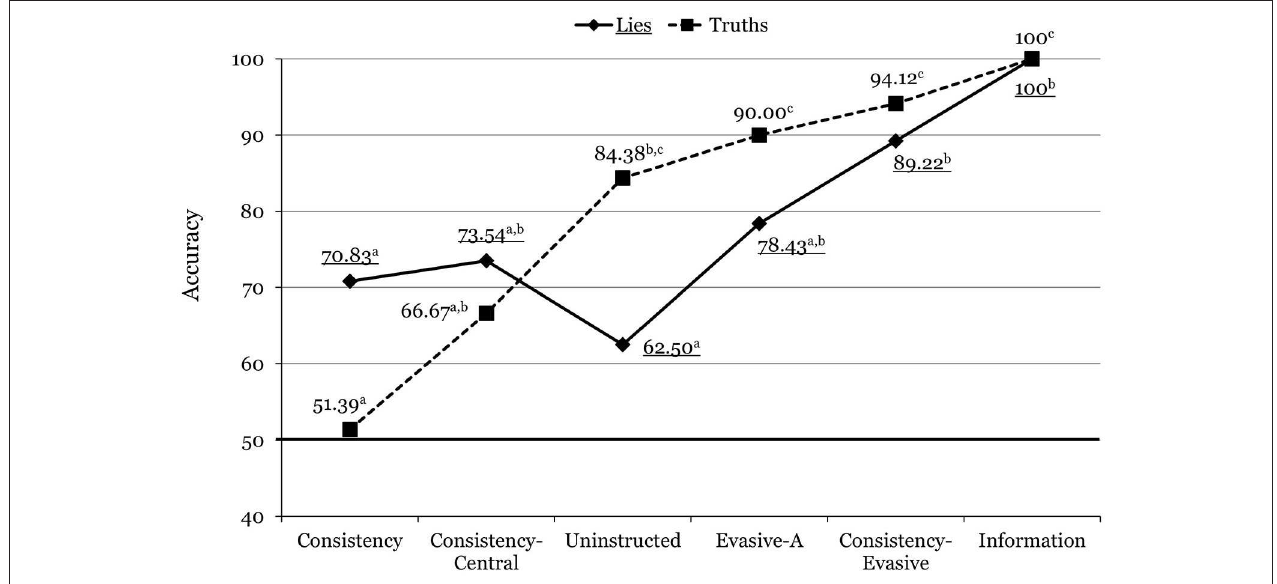
FIGURE 3 | Mean accuracy rates across the different conditions for experienced officers in Experiment 2. For each line, means with different superscripts differ significantly from each other. Underlined values correspond to